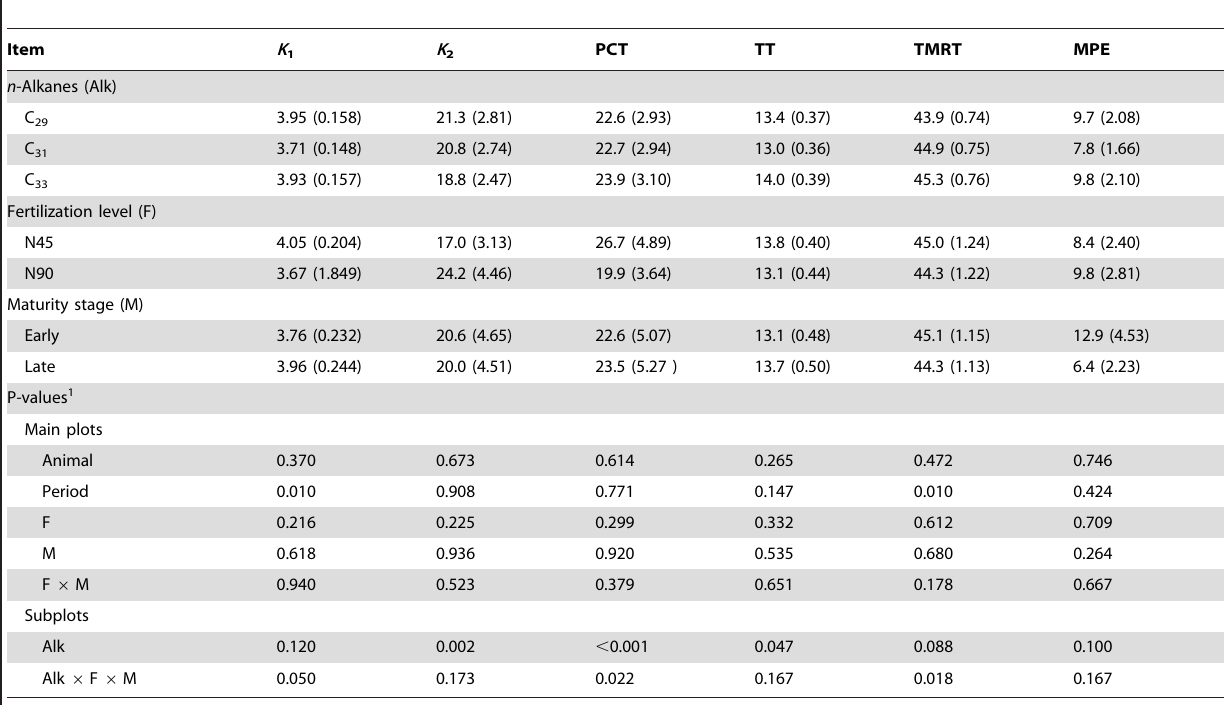
Table 3. Passage kinetics of d 13 C labeled odd-chain n -alkanes (C 29 , C 31 , C 33 ) in dairy cows fed grass silages of early and